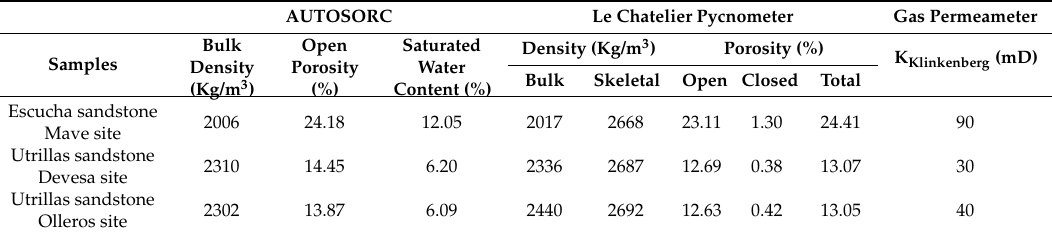
Table 4. Mean values of hydraulic properties carried out by different techniques for Escucha and Utrillas